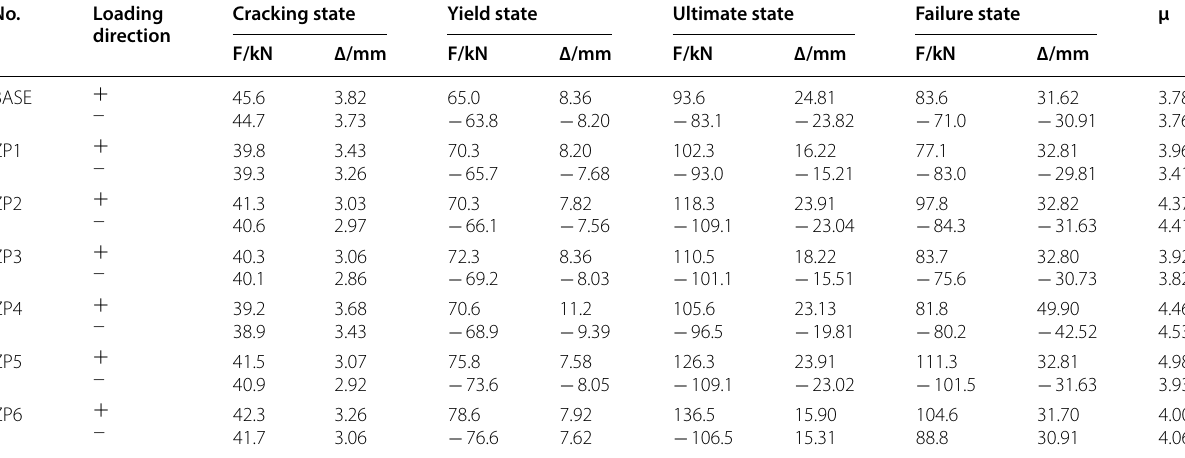
Table 3 Strength and deformation extent at critical